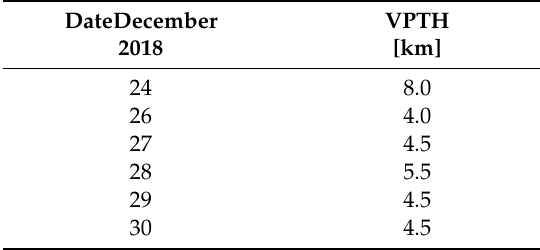
Table 1. VPTH from satellite and ground-based VIS camera images from 24 to 30 December 2018 used for the VPR ash and SO 2 retrievals .